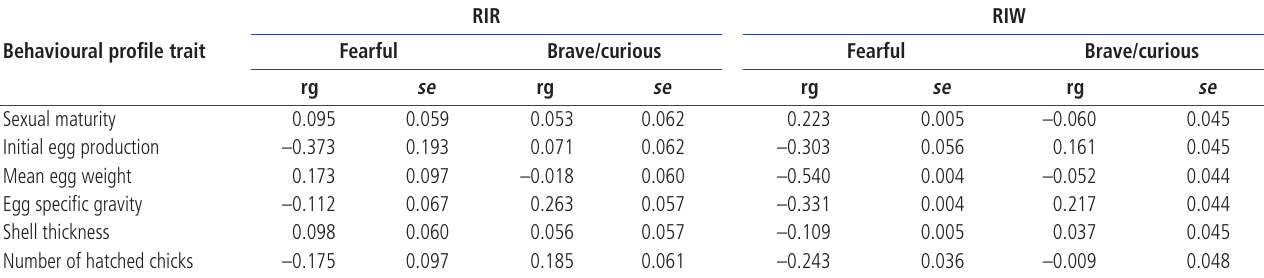
Table 4. Genetic correlations (rg) and their standard errors (se) between the performance traits and behaviour of RIR and RIW hens RIR RIW Fearful Brave/curious Fearful Behavioural profile trait